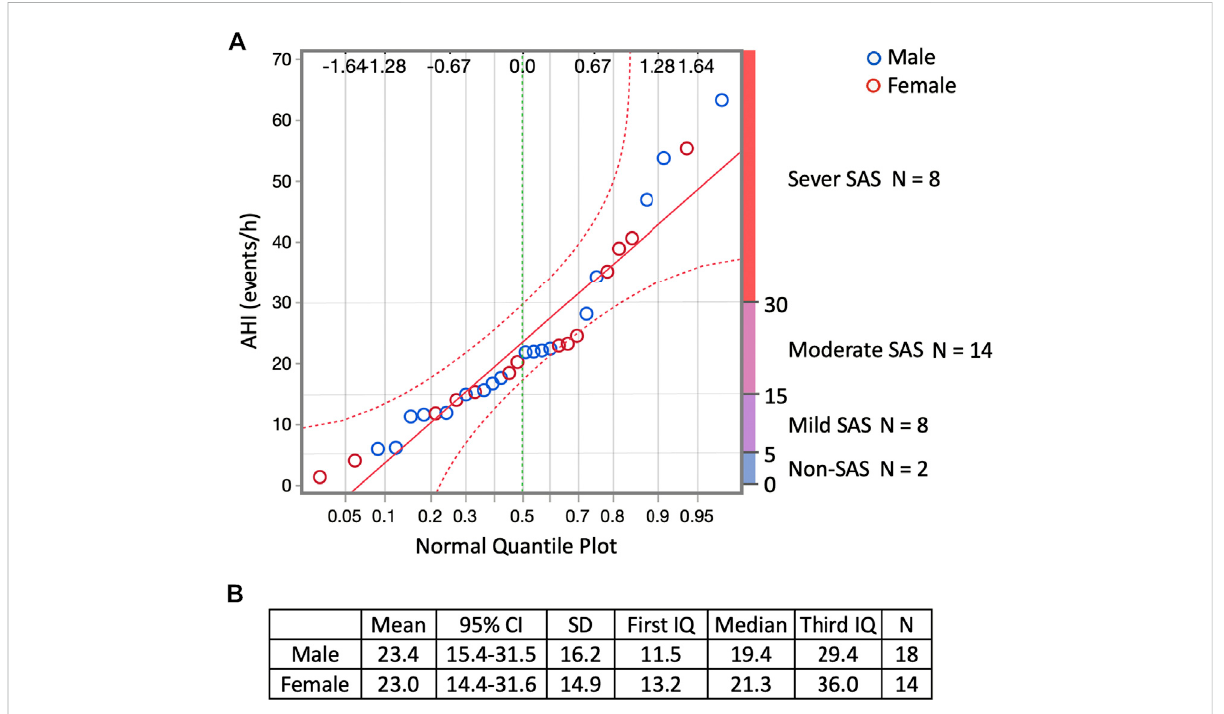
FIGURE 2 Responses regarding sleep-disordered breathing by the participants who responded to the YHAB survey. (A) Normal quantile plot of AHI and sleep-disorderedbreathingcategories establishedbytheICSD.Bluecirclesindicatemales,redcirclesindicatefemales.Theupperabscissaindicates the normal quantile scale. Lower abscissa shows the cumulative empirical probability of each value. (B) Sex-speci fi c dataset of the AHI. YHAB, Yamanashi Healthy Active Longevities Biobank for healthy aging biosciences; AHI, apnoea-hypopnoea index; ICSD, International Classi fi cation of Sleep Disorders; SAS, sleep apnoea syndrome; CI, con fi dence interval; SD, standard